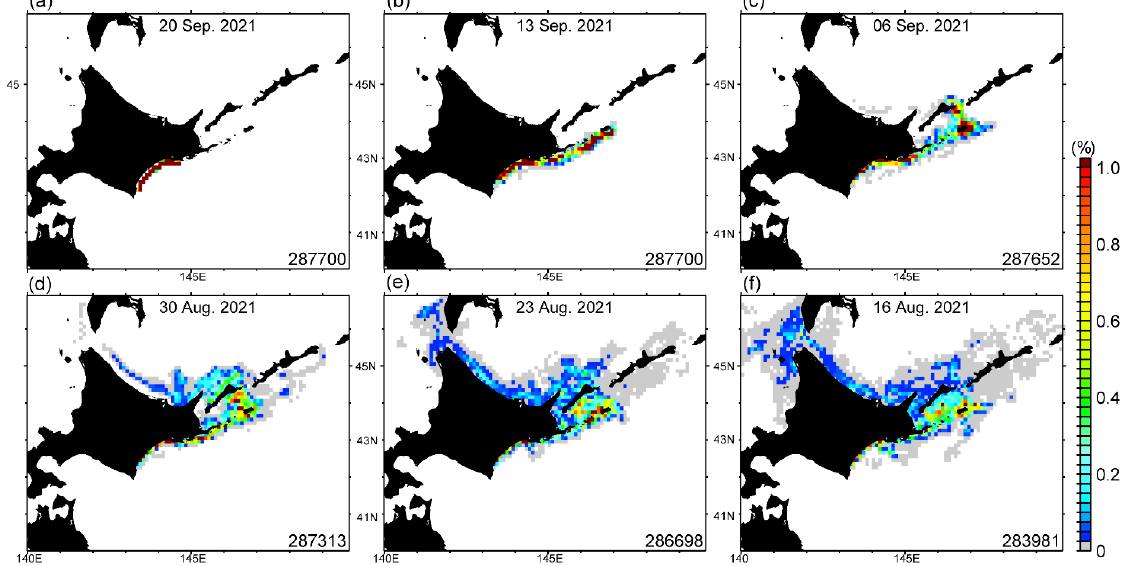
Figure 9. Relative frequencies of particles at 1/10 ◦ resolution. A total 287,700 particles were released on 20 September 2021 from coastal waters off southeast Hokkaido. The panels show the positions of the particles at 7-day intervals: ( a ) 20 September, ( b ) 13 September, ( c ) 6 September, ( d ) 30 August, ( e ) 23 August, and ( f ) 16 August. The number in the lower-right corner in each panel is the number of particles in each panel; particles that were outside of the illustrated domain and could not be tracked were